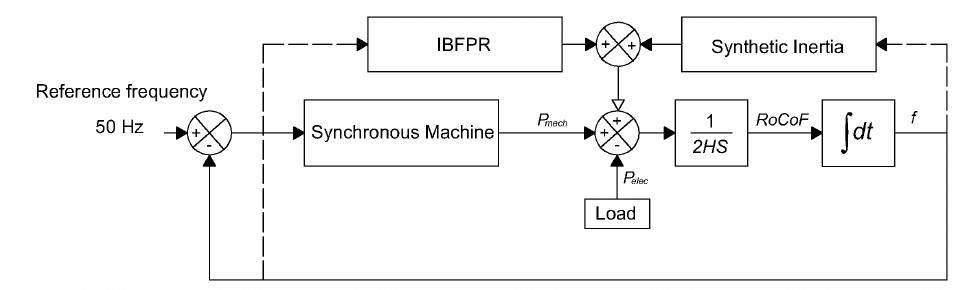
Figure 3. Simplified representation of the IEEE 9 bus model. Blocks linked by the solid line represent the conventional swing equation given by Equation (1). Represented with dashed lines, the respective frequency signals to the blocks of IBFPR and synthetic inertia, which add power to the system.